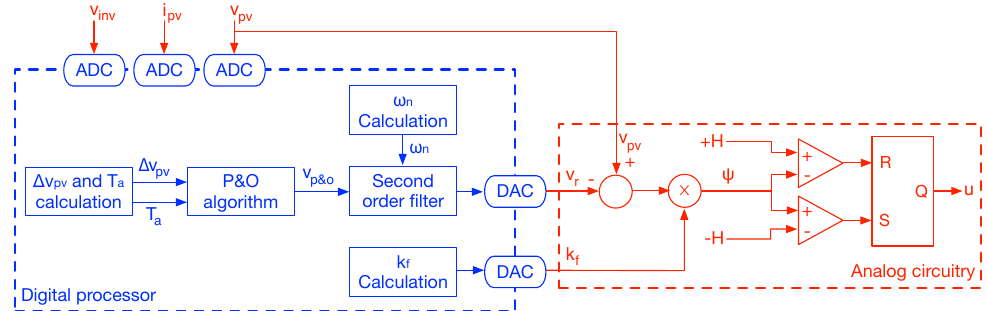
Figure 9. Block diagram of the mixed analog-digital